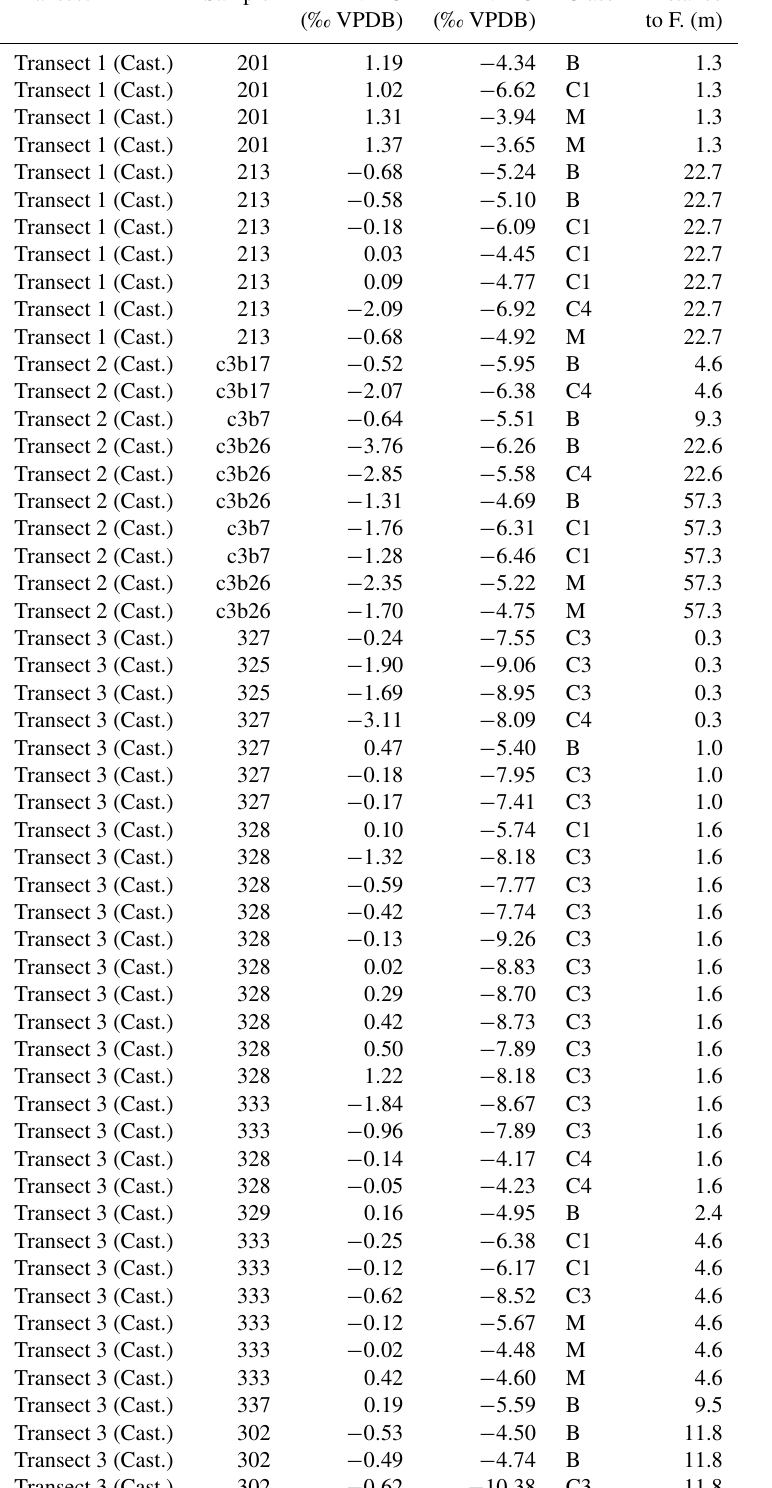
Table 2. Carbon and oxygen isotope values of bulk carbonates for Castellas Fault zone and D19 Fault zones. B: bulk measurement; M: micrite value; C1, C3, C4, and C5: cement isotopic value; FR: fault rock isotopic